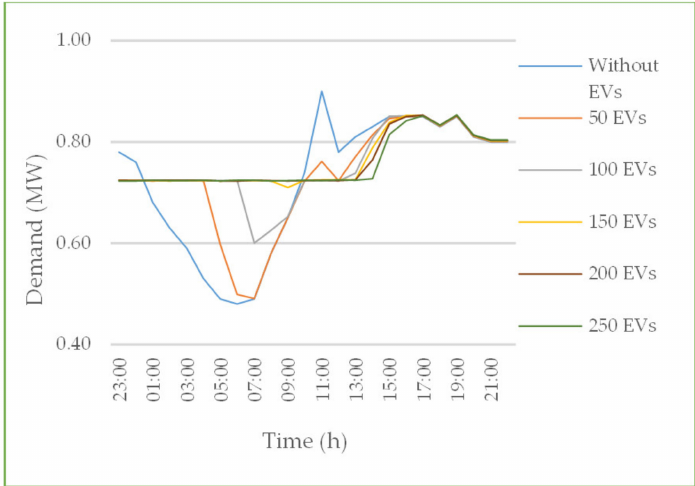
Figure 12. The effect of charging/discharging on LC2 when N cars have a custom mobility pattern for valley filling and random EV mobility pattern for peak shaving: N = 50, 100, 150 , 200, 250